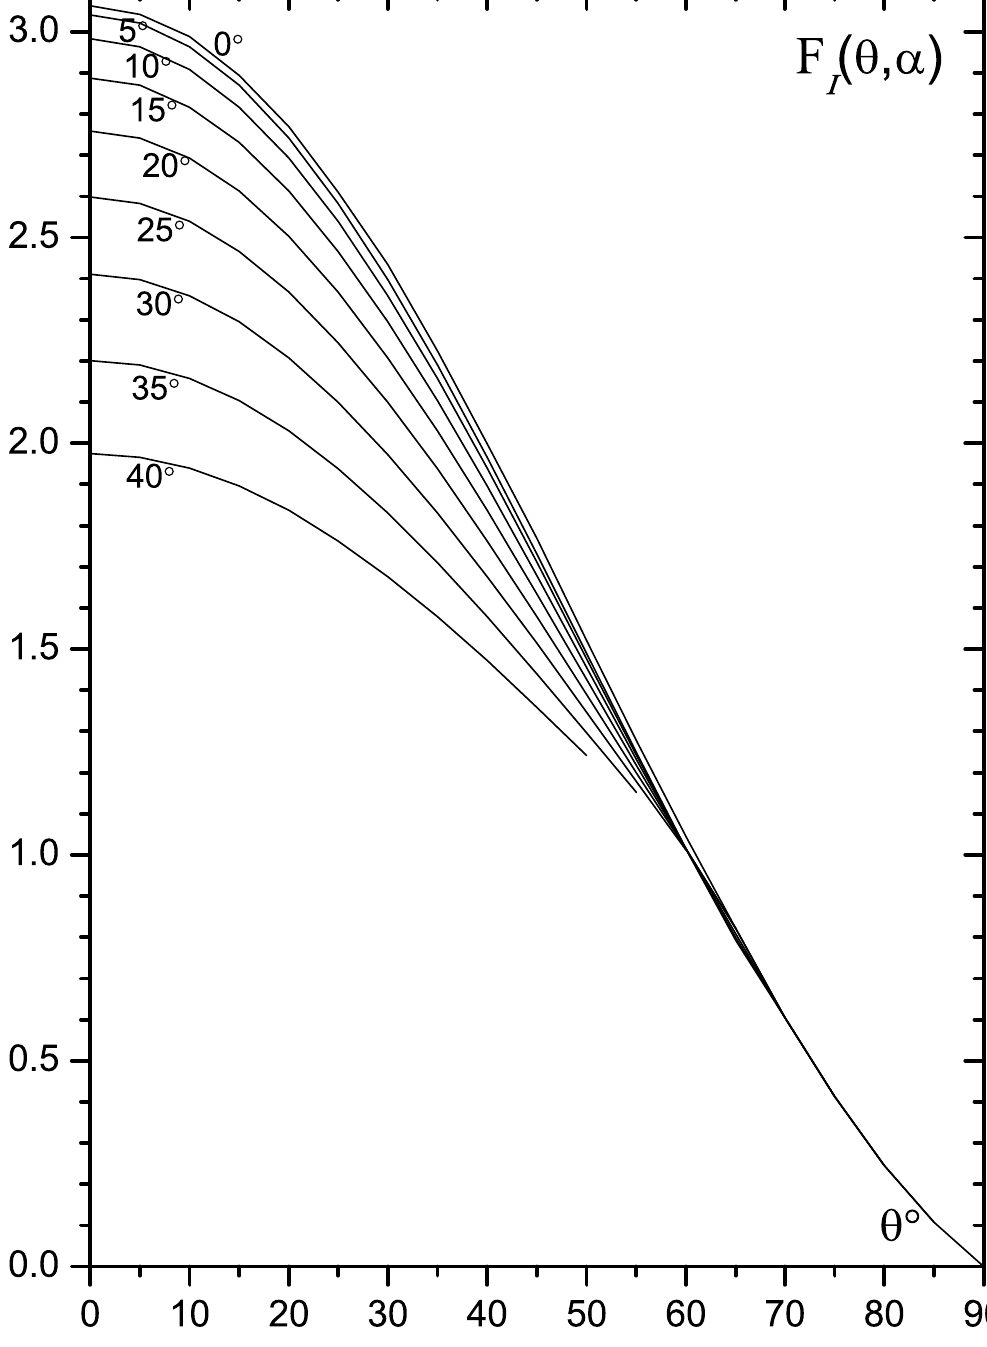
Figure 3. The angular distribution of cotinuum radiation F I ( θ , α ) (without the factor Const / R 2 ). The numbers denote the inclination angle α